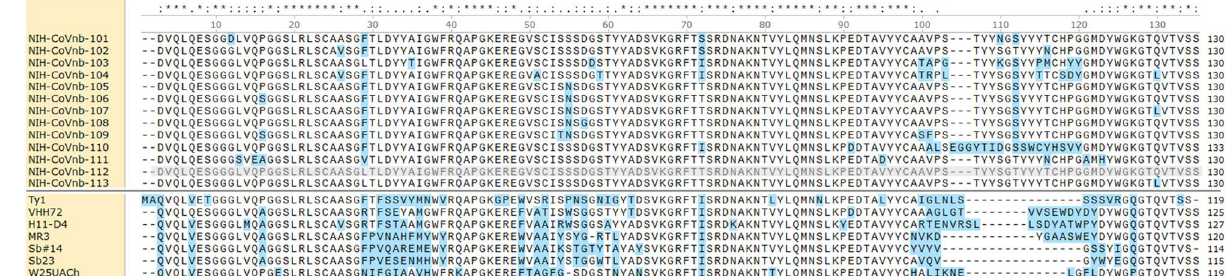
Figure 2. Protein sequences for novel nanobodies that bind to the SARS-CoV-2 spike protein receptor binding domain. Single letter amino acid codes. Clustal Omega algorithm used for alignment. Blue highlights indicate sequence diversity with NIH-CoVnb-112, highlighted in gray, set as the reference sequence for comparison. For comparison, seven previously reported nanobody sequences have clearly distinct sequences: Ty1 23 , VHH72 24 , H11-D4 19 , MR3 20 , Sb#14 21 , Sb23 22 , and W25UACh 25 and possess shorter CDR3 domains (represented in NIH- CoVnb-112 by amino acids 99–120).